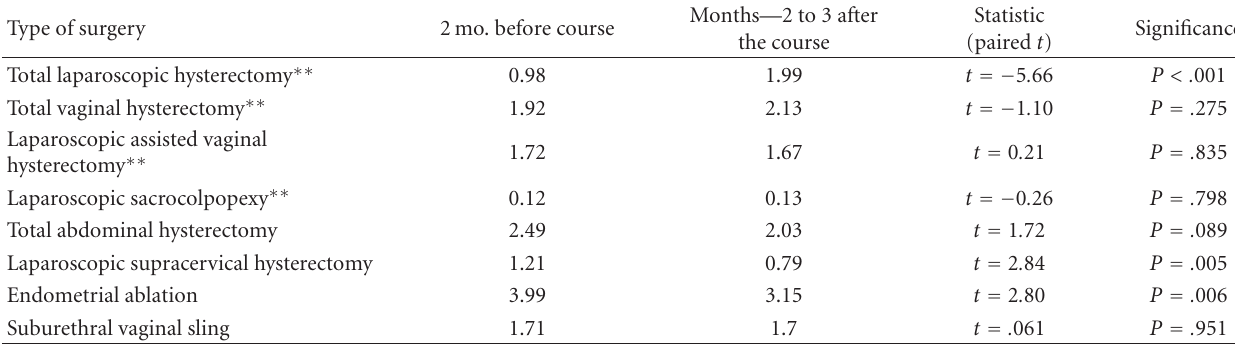
Table 1: Numbers of gynecological surgeries ( n = 99).